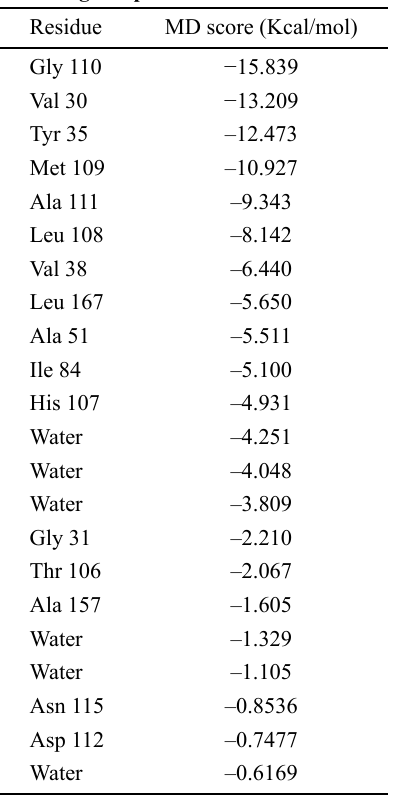
Table 3. The participated residues of p38MAPK in ligand-protein